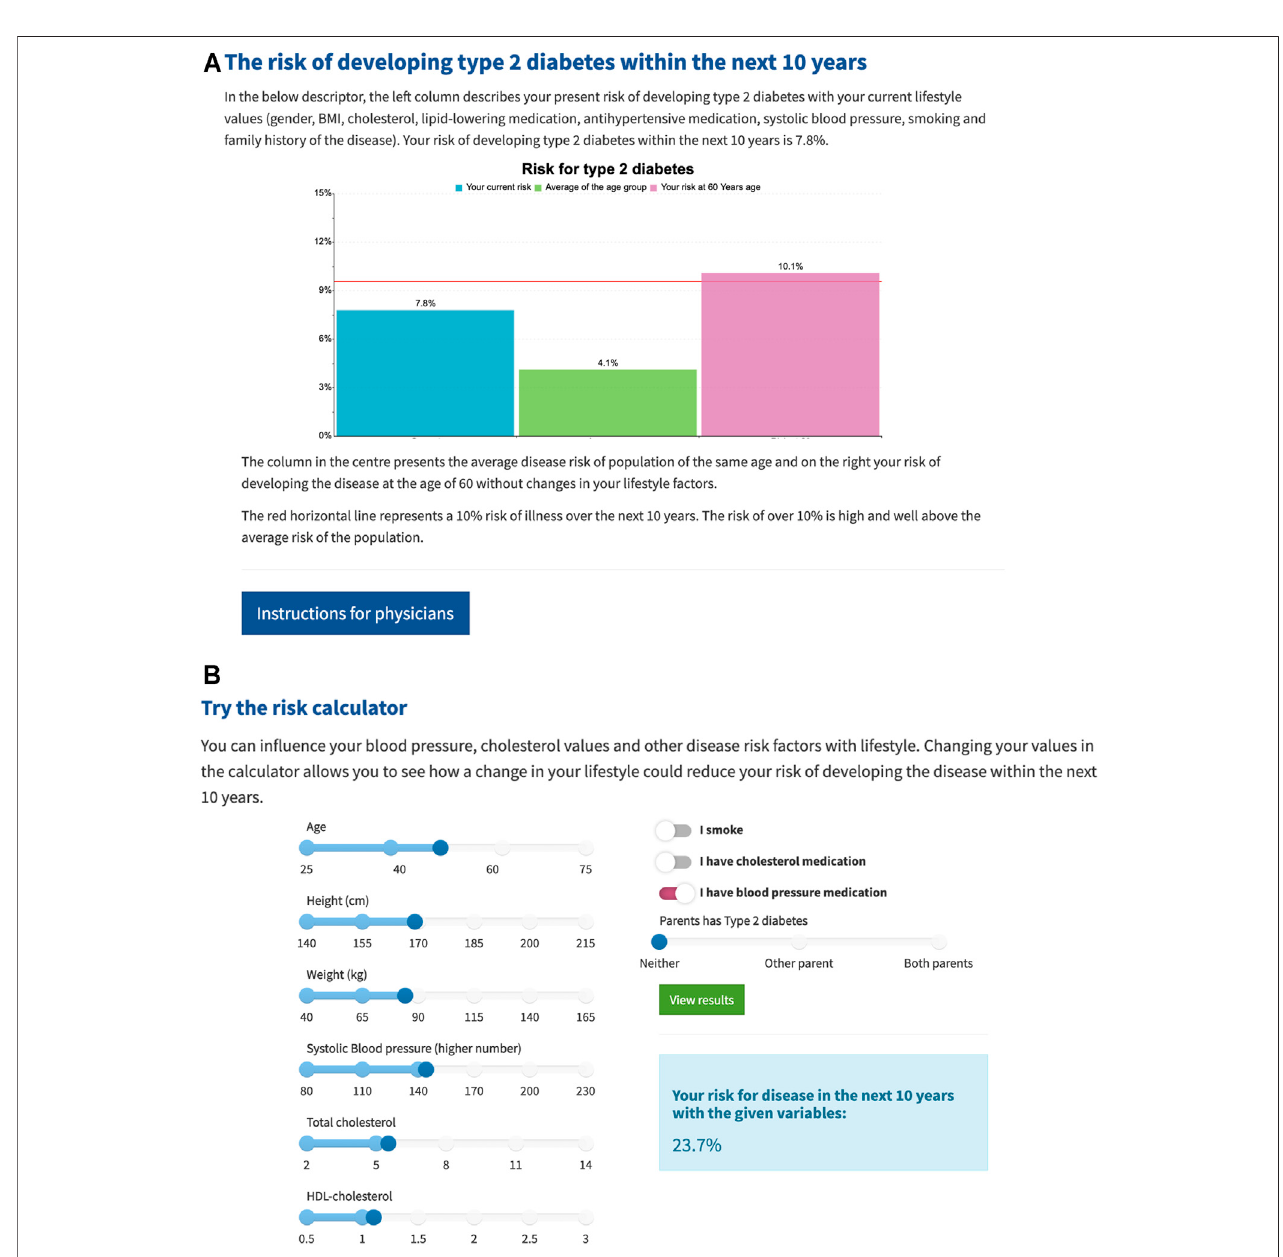
FIGURE 2 | (A) The three columns from left to right present: participant ’ s absolute risk at current age, average absolute risk in similar age population and participant ’ sestimated10-yearsriskattheageof60.Redlineat10%presentsthe “ high ” riskthreshold. (B) Participantswereabletochangetheirlifestylefactorsinarisk calculator which could be seen as changes in the above risk